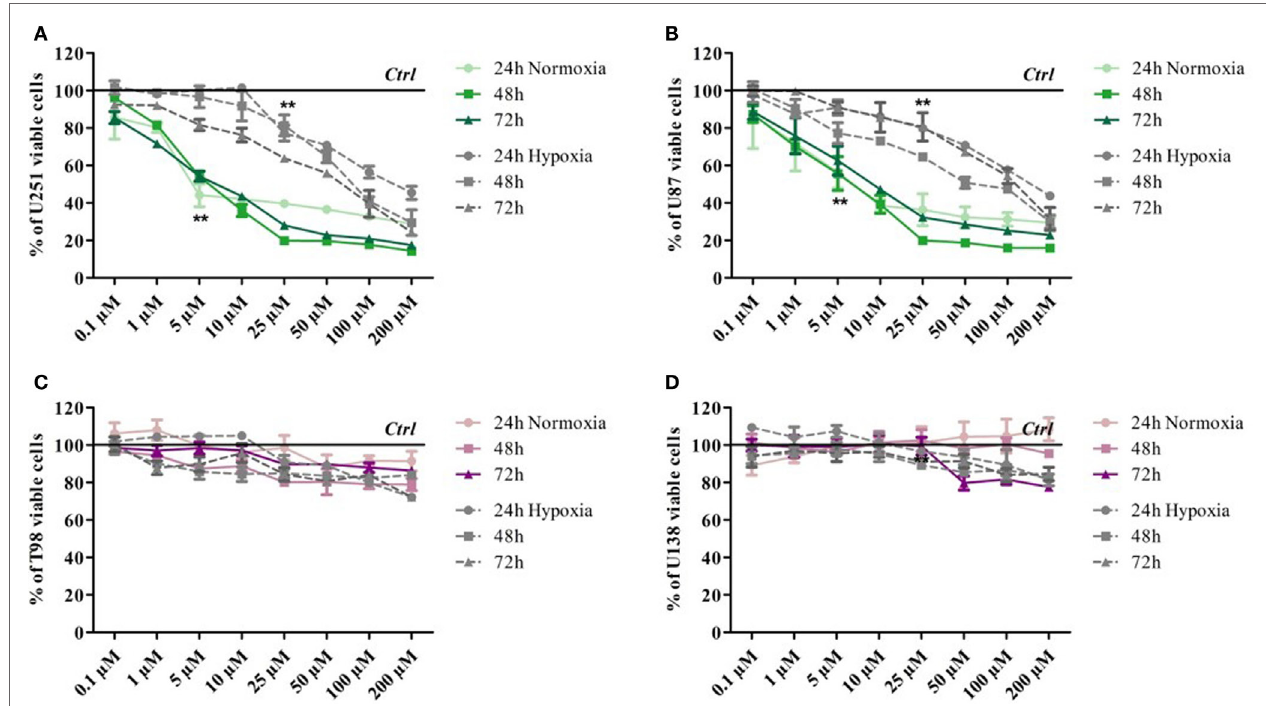
FigUre 1 | Dose–response viability of responsive and resistant cells after temozolomide (TMZ) treatment . Cell viability was assessed by means of a Trypan blue exclusion test and expressed as the percentage of viable cells after 24, 48, or 72 h of treatment at increasing doses of TMZ under normoxic and hypoxic